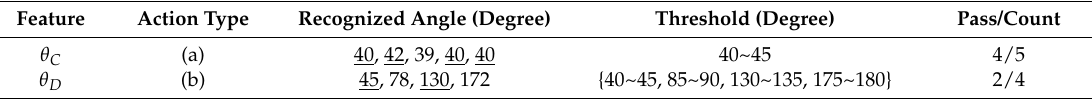
Table 5. Recognition results of the simple flexion exercises in physical therapy [60].